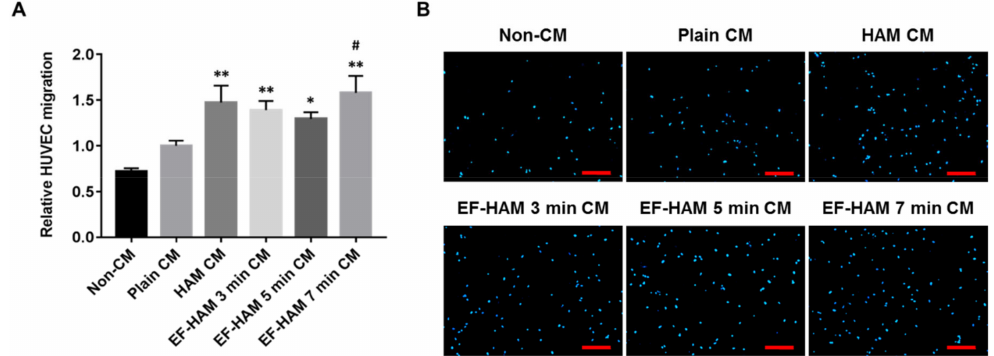
Figure 5. EF-HAM 7 min CM induced a higher transwell migration capacity in HUVECs than plain CM. ( A ) Relative HUVEC migration when co-cultured with SkM-seeded HAM and EF-HAM CM compared with plain CM. ( B ) Representative images of migrated HUVECs, nuclear-stained with DAPI, at the bottom of transwell inserts. The values are represented as mean ± SEM (* p < 0.05 or ** p < 0.01, compared with non-CM control; # p < 0.05, compared with plain CM; One-way ANOVA). Scale bar: 200 µ